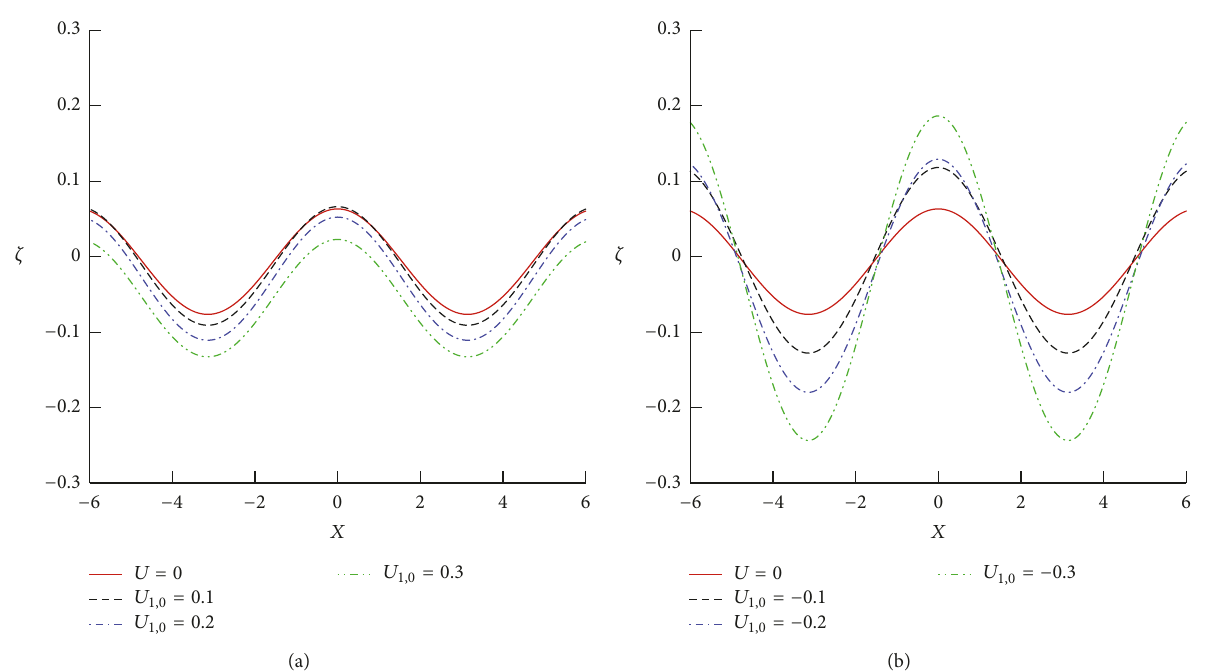
Figure3:Variationofthehydroelasticwaveprofilesversus 𝑥 fordifferentcurrentspeed 𝑈 1,0 .(a)Afollowingcurrent. (b)Anopposingcurrent.